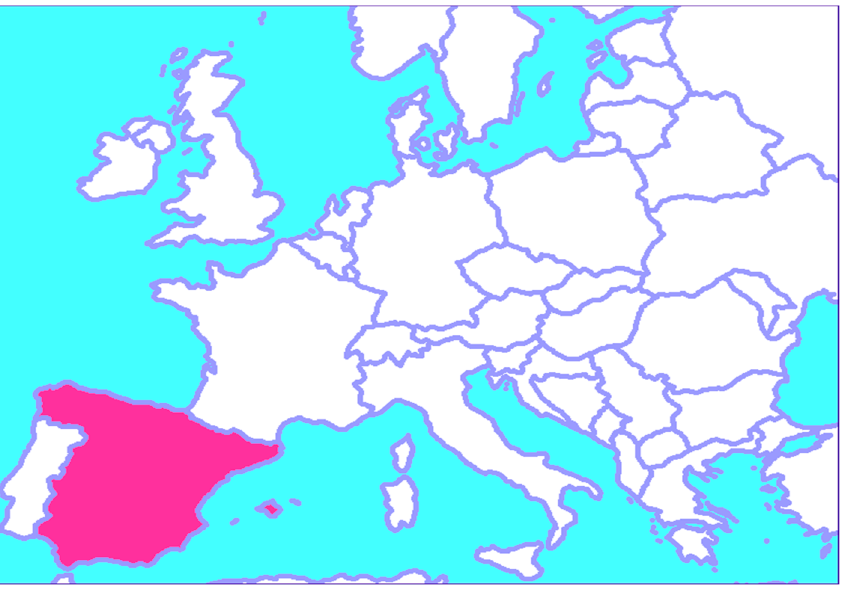
Table 1. Data for Spain.